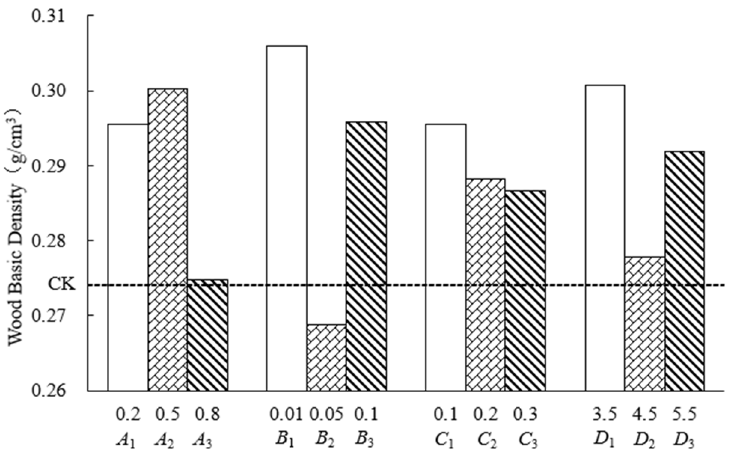
Figure 4. Effects of four factors (all with three levels) on wood basic densities of dyed red-heart Chinese fir wood after one year. A is reactive dye (%) with three levels of 0.2% ( A 1 ), 0.5% ( A 2 ), and 0.8% ( A 3 ). B is penetrant (%) with three levels of 0.01% ( B 1 ), 0.05% ( B 2 ), and 0.10% ( B 3 ). C is KH 2 PO 4 (%) with three levels of 0.1% ( C 1 ), 0.2% ( C 2 ), and 0.3% ( C 3 ). D is pH with three levels of 3.5 ( D 1 ), 4.5